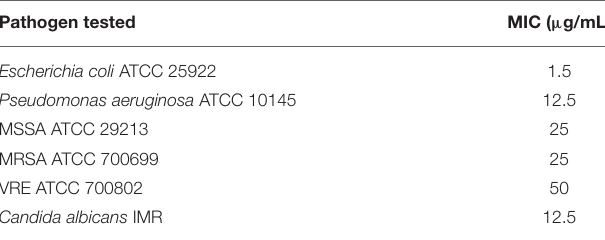
TABLE 3 | MIC of active fraction produced by strain MSt1 T against six